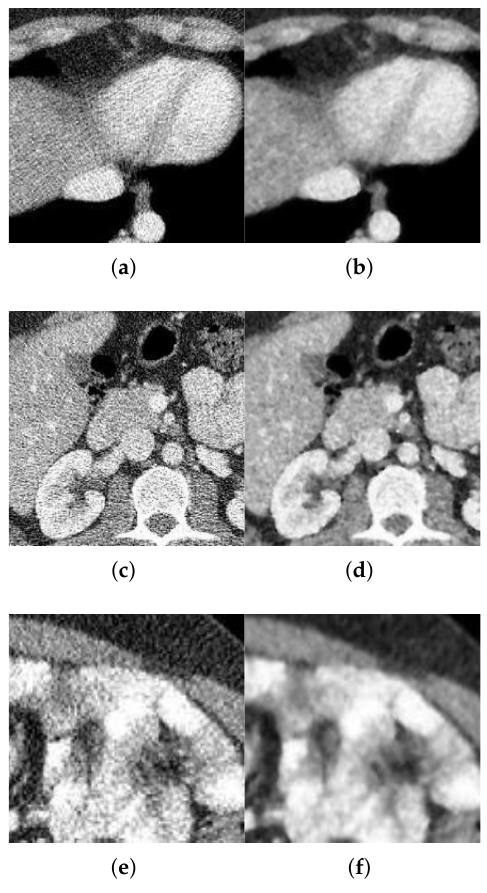
Figure 13. Method outputs for LDCT abdominal images. ( a ) Quater-dose LDCT image 1. ( b ) Method output. ( c ) Quater-dose LDCT image 2. ( d ) Method output. ( e ) Quater-dose LDCT image 3. ( f ) Method